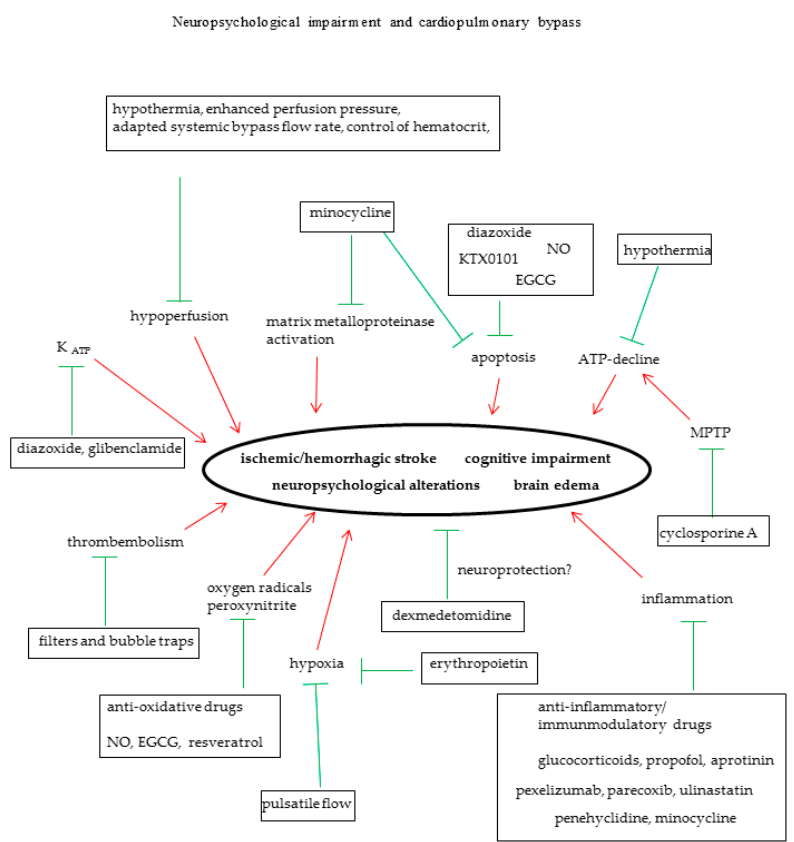
Figure 1. Pathophysiology of neurological deficits in the course of cardiopulmonary bypass and possible pharmacological and non-pharmacological interventions. Red arrows indicate negative effects on the brain, green lines show protective strategies. EGCG, epigallocatechin-3-gallate; NO, nitric oxide; K ATP , ATP-sensitive potassium channel; MPTP, mitochondrial permeability transition pore.